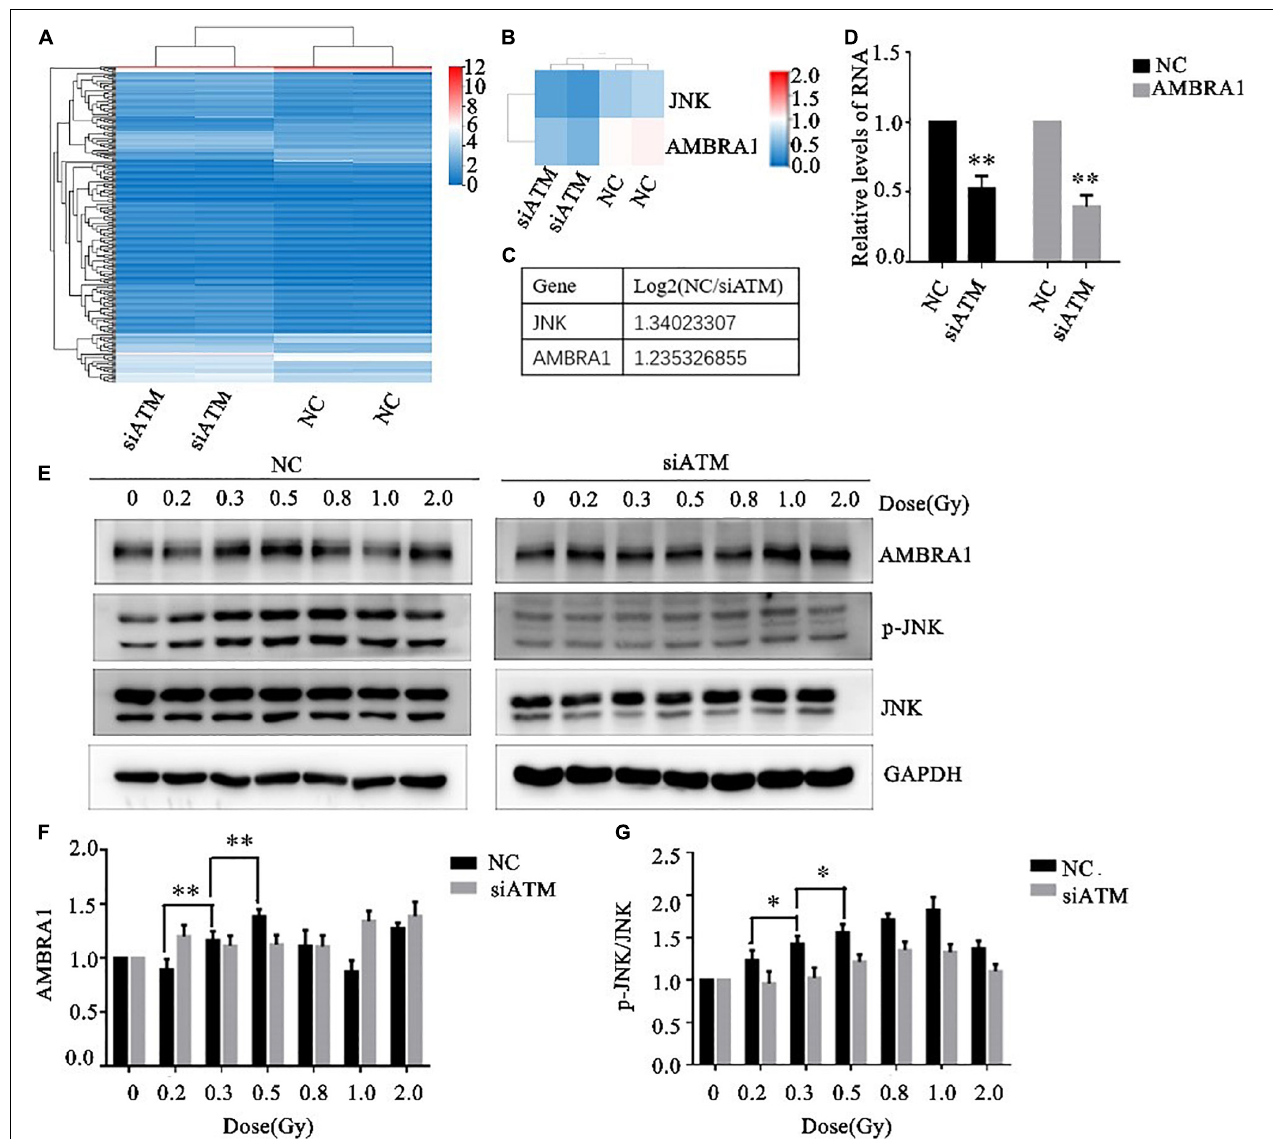
FIGURE 4 | Ataxia telangiectasia mutated (ATM) regulates changes in autophagy pathway-related molecules. (A–C) Transcriptome sequencing analysis of the differences in autophagy pathway–related molecules between the control group and the ATM downregulated group. The differences in JNK and AMBRA1 between the two groups were the most significant. (D) The sequencing results were verified by PCR. (E–G) Changes in the levels of p-JNK and AMBRA1 in the control group and the ATM-knockdown group under low-dose radiation. ** p < 0.01, * p <